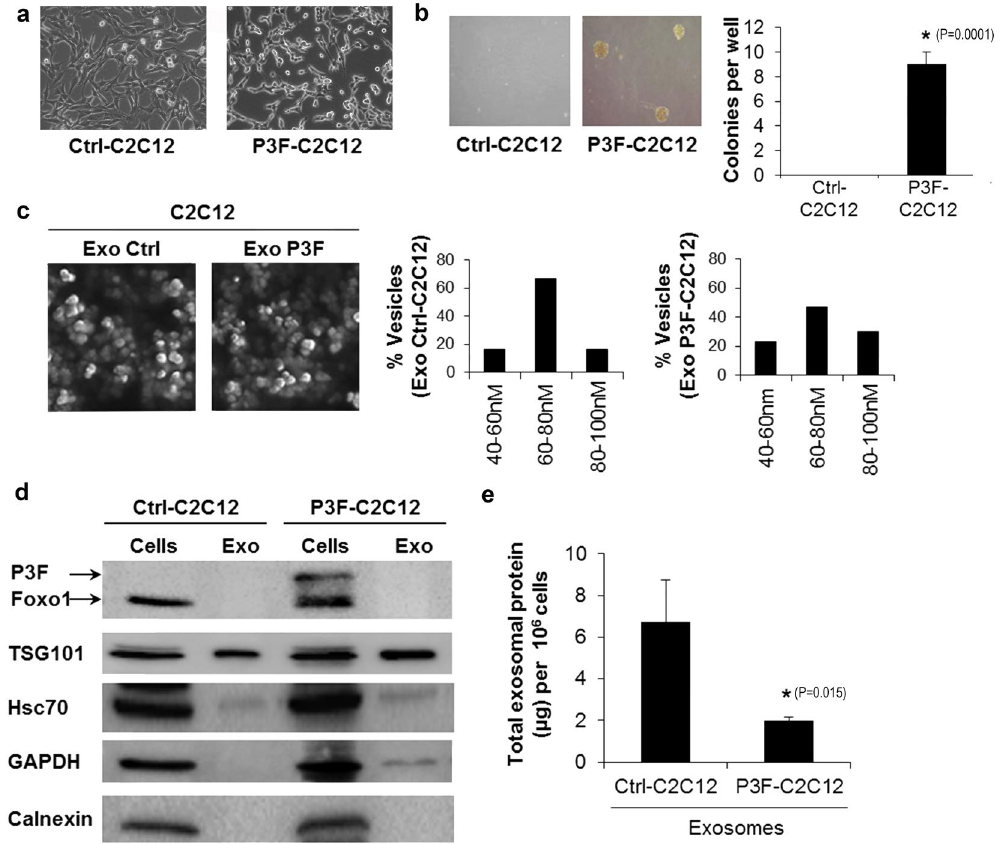
Figure 1. Exosomes are released by P3F-C2C12 and Ctrl-C2C12 mouse myoblasts. ( a ) Representative light microscopy images of C2C12 cells transduced with either empty vector (Ctrl-C2C12) or PAX3-FOXO1 expressing vector (P3F-C2C12). ( b ) Number of colonies formed by the indicated cells in soft agar. Values presented are means of 3 independent experiments and images shown are representative light microscopy pictures of colonies taken after 1 week. ( c ) Representative SEM micrographs of exosomes (Exo) purified from the indicated cells with respective histograms showing the percentage of extracellular vesicles within each diameter range. ( d ) Western Blot analysis of the indicated proteins in exosomes and respective cells. Average exosome proteins ( μ g) per 1 million cells as quantified by Bradford assay. Bars represent standard deviation. Asterisks denote a statistically significant difference (p-value <